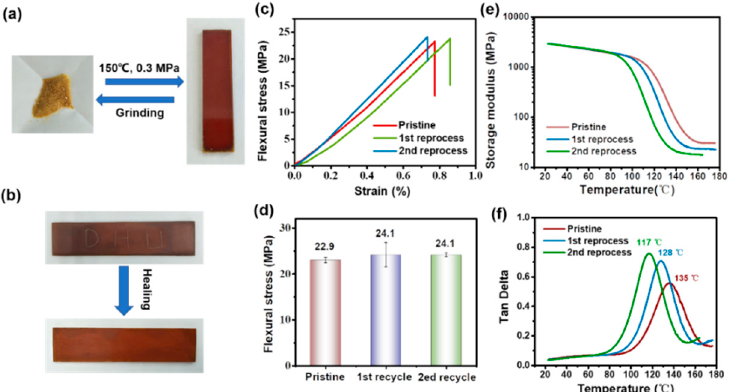
Figure 2. ( a ) Reversible reprocessing of the PHT. ( b ) A scratched PHT bar before and after healing. ( c ) Representative flexural stress versus strain curves ( d ) and flexural stress of pristine and reprocessed PHTs. ( e ) Storage modulus and ( f ) tan δ versus temperature curves of pristine and reprocessed PHTs.